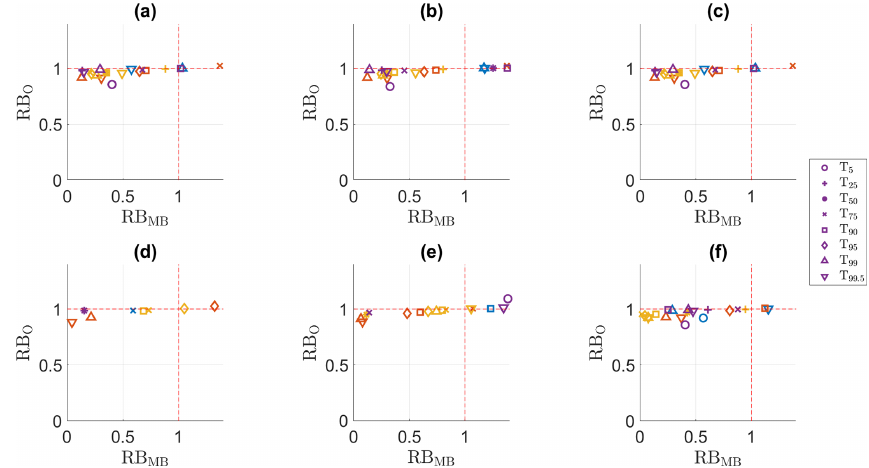
Figure 5. RB MB versus RB 0 for the temperature indices in the validation period. (a) QDM, (b) mQDM, (c) MBCn, (d) MRQNBC, (e) dOTC, (f) R 2 D 2 . Winter: blue, spring: ochre, summer: yellow, autumn: